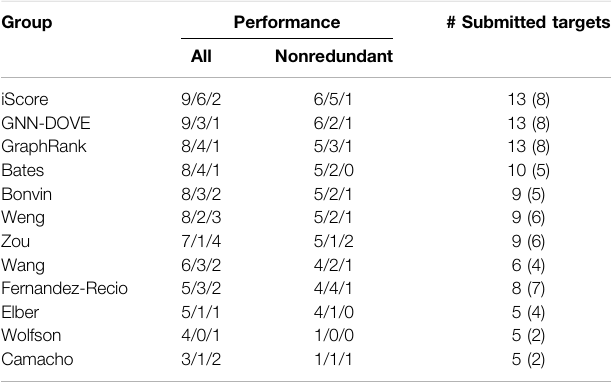
TABLE 5 | Ranking of GNN-DOVE among other scorer groups on the CAPRI scoring dataset. Group